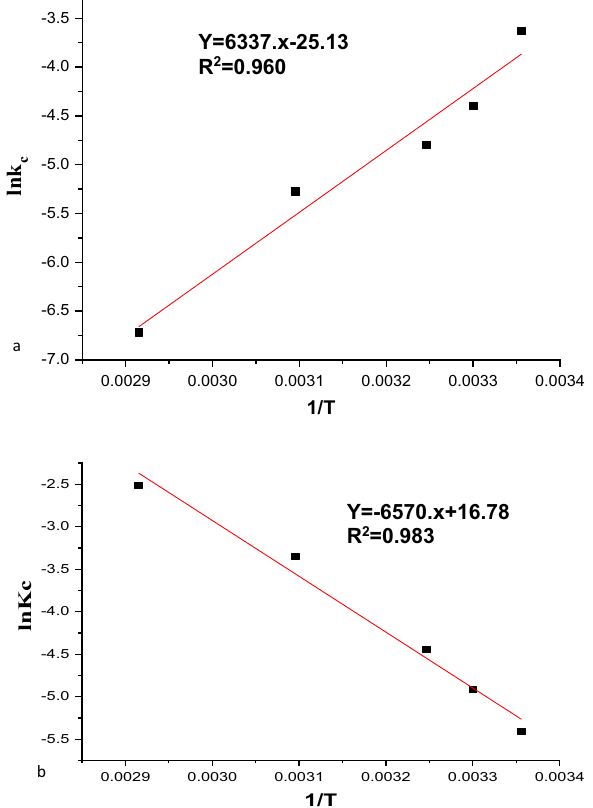
Figure 16. Thermodynamic for the adsorption of MG onto ( a ) nano bentonite and ( b ) MgO impregnated